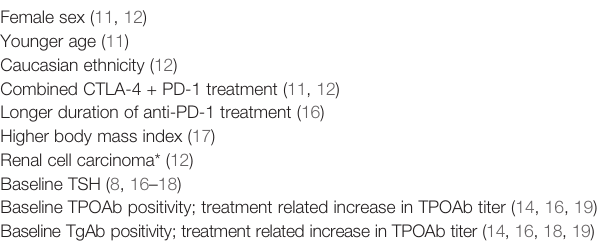
TABLE 2 | Demographic and biochemical factors associated with development of thyroid